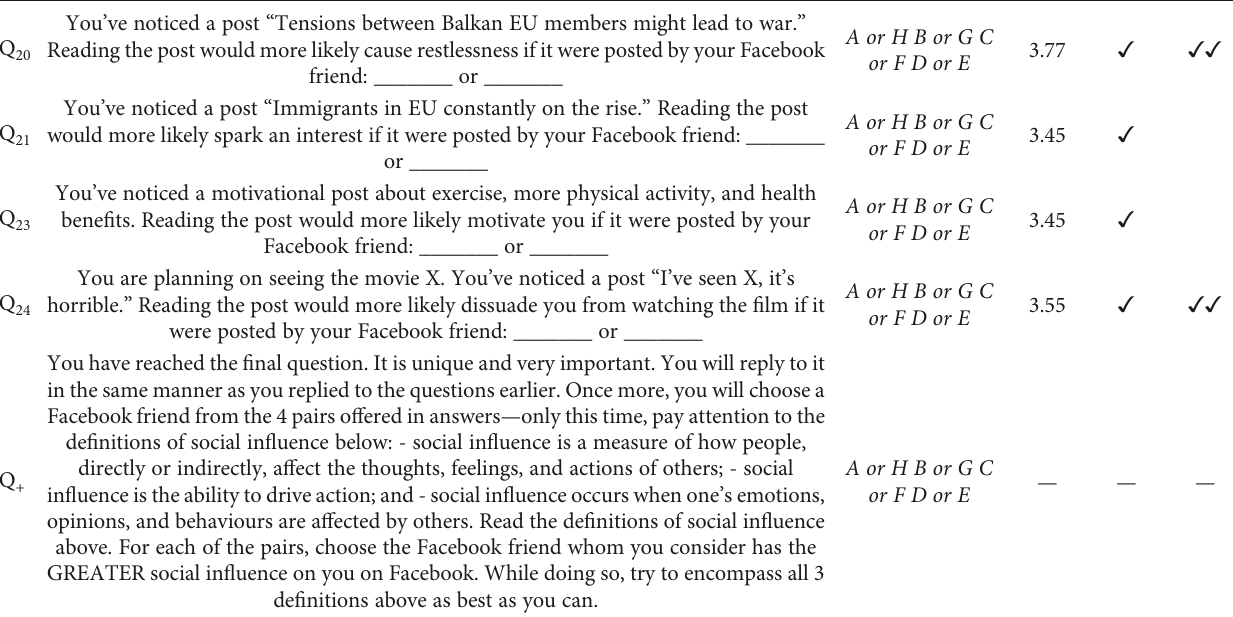
Table 7: Main questionnaire given to